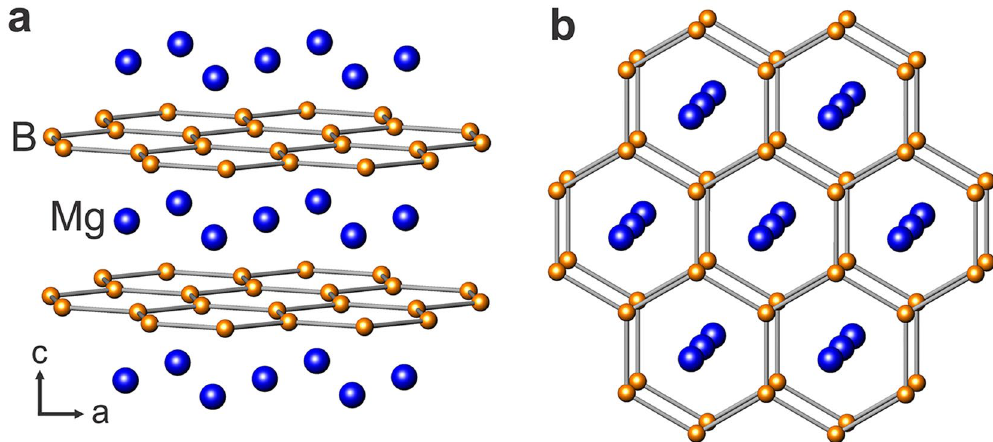
Figure 2. Schematic design of layered MgB 2 structure. ( a ) Along the a-axis, ( b ) along the c-axis.